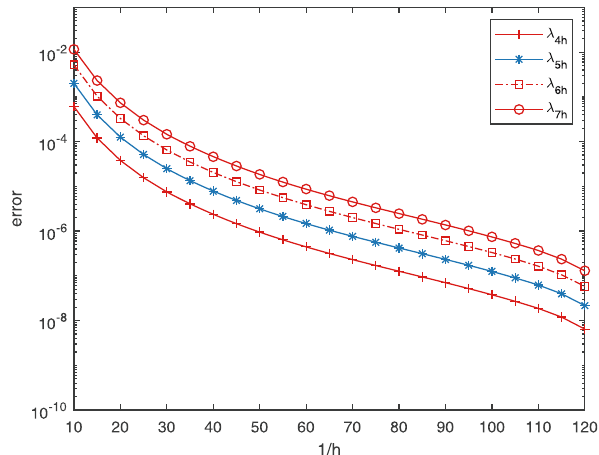
Figure 5: Errors between numerical solutions and the reference solution for = m 4, 5, 6, 7 and = R 1 .